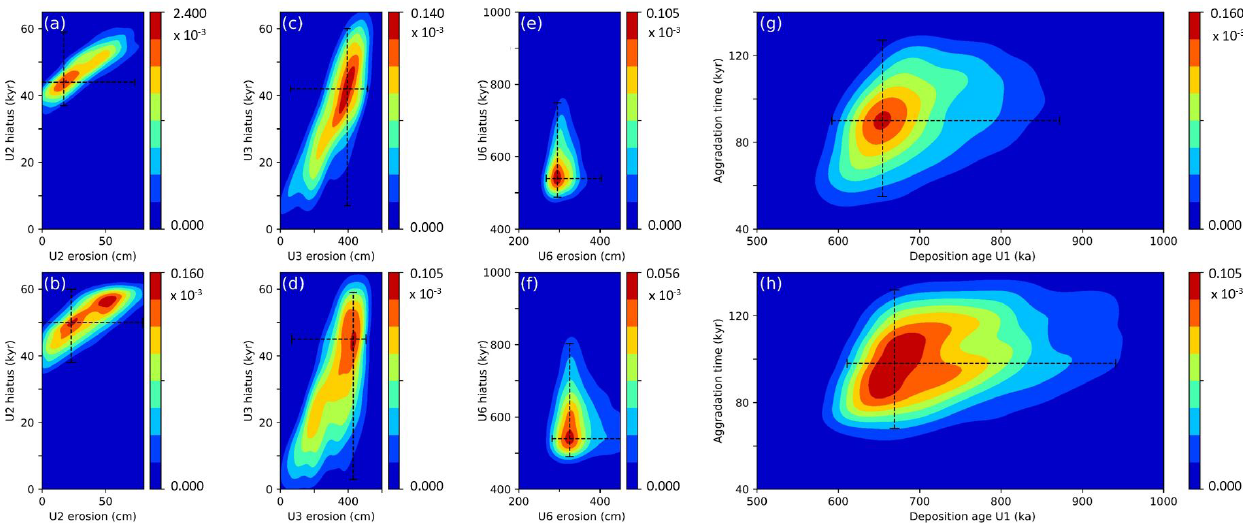
Figure 7. Density plot of the possible model outcomes for scenario 4. Any simulation that returned a reduced χ 2 smaller than 1.83 is considered to be significant and is included as a possible solution in the density plots. The density of significant solutions is shown by colour coding. The four upper panels (a, c, e, g) represent the parameters of simulations ( n = 486) characterised by a 26 Al / 10 Be of 6.75, and the lower panels (b, d, f, h) represent the parameters of simulations ( n = 1695) with a 26 Al / 10 Be of 7.40. For each parameter, the most likely value (i.e. the value with highest density of significant solutions) is reported along with its 95% confidence interval (2 σ ). The 95% confidence interval is derived from the 2.5% and 97.5% limits of the kernel cumulative density